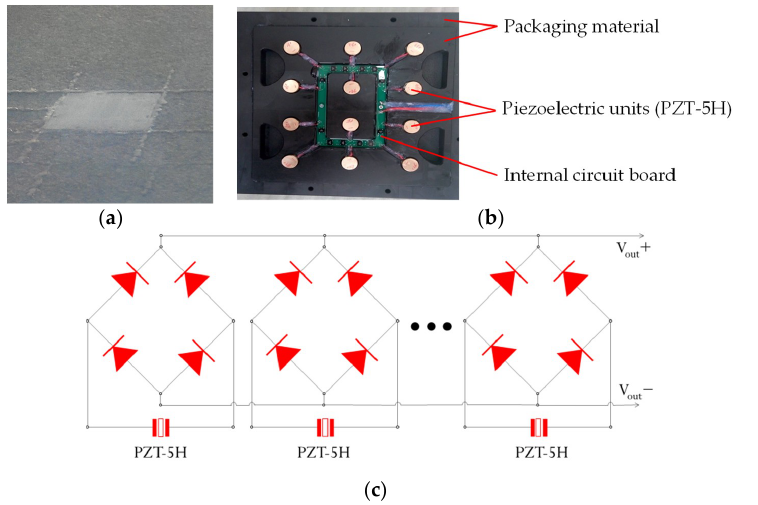
Figure 3. Prototype of the piezoelectric energy harvester (PEH) [23,24]: ( a ) PEH installation in pavement; ( b ) Details of PEH inside design; ( c ) Connection of the piezoelectric units.